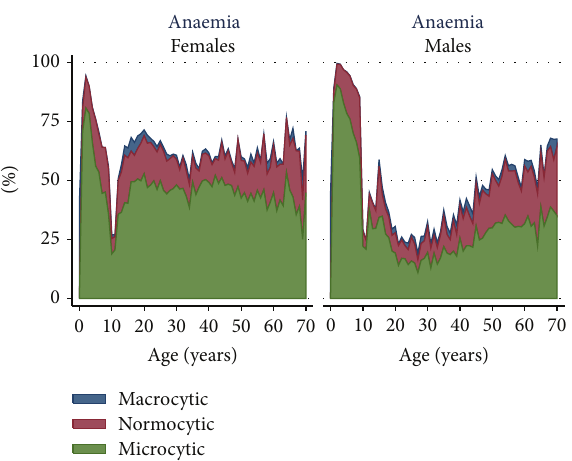
Figure 5: Prevalence of macrocytic, normocytic, and microcytic anaemia by age in males and